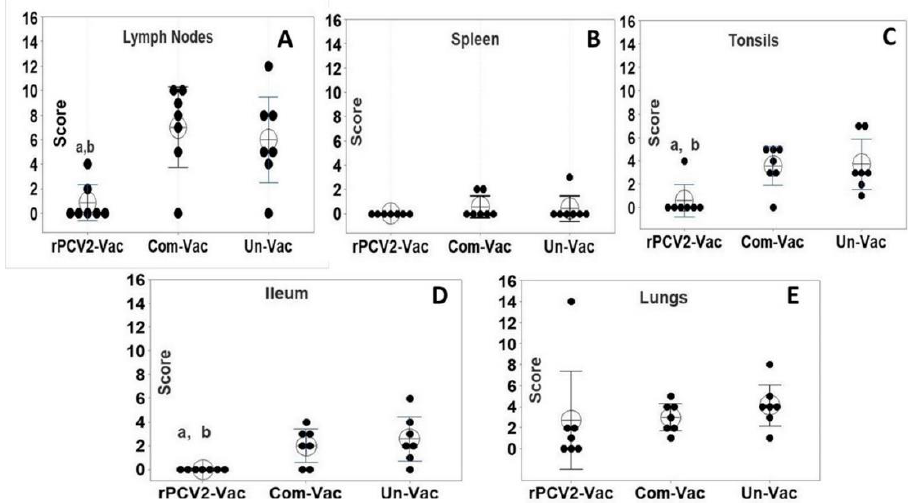
Figure 8. Lesion scores in tissues. Assessment of lesion scores resulting from viral challenge is represented as the sum of the scores for each tissue ( A – E ). Gross lung lesions were scored from 0%–100% to represent the % area of affected lung. Microscopic lesions were scored with a scale of 1–4; where 1 = single follicle or focus staining 2 = rare to scattered staining, 3 = moderate staining 4 = strong widespread staining. X axis: groups, Y axis: scores, dots: values for the individual pigs, horizontal bar with the large circle: group mean, bars: 95% confidence interval of the means, a: Significantly different from the unvaccinated control, b: Significantly different from the commercial vaccine group, ( p < 0.05) by a Mann–Whitney U test.